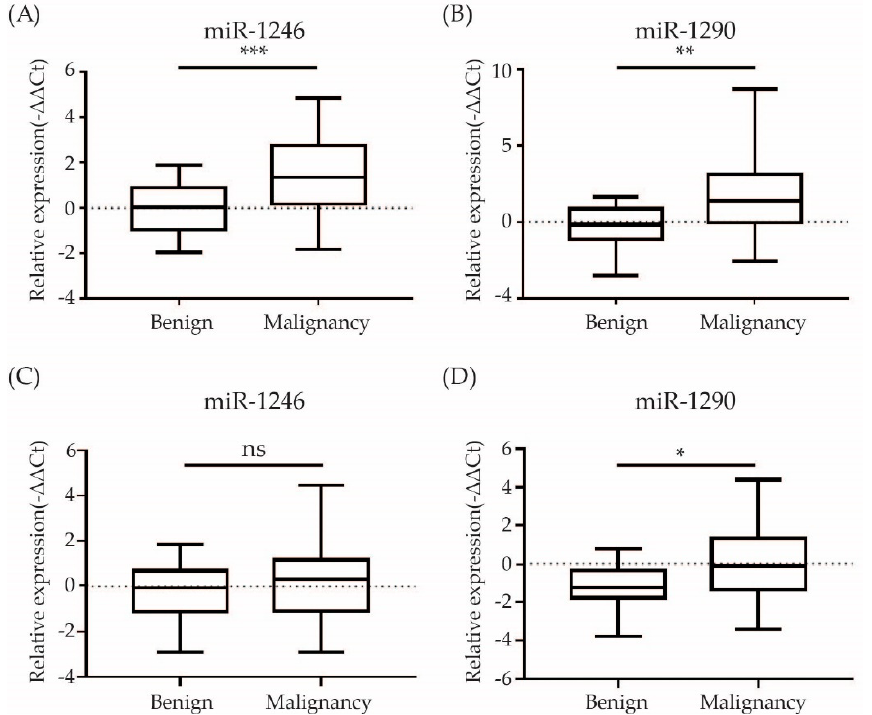
Figure 3. Evaluation of the two selected miRNA expression values in FFPE and serum samples by quantitative RT-PCR ( A , B ) FFPE: A total of 45 (15 benign ovarian neoplasm, 67 EOC) ( C , D ) Serum: A total of 84 (13 benign ovarian neoplasm, 71 EOC) were used for qRT-PCR. * p < 0.05, ** p < 0.01, *** p < 0.001. ns : not significant